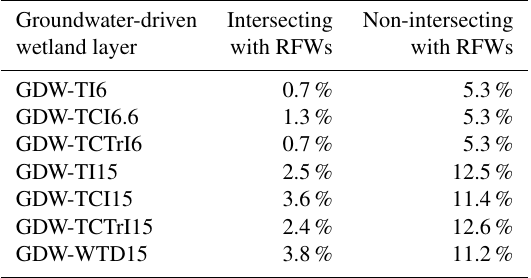
Table 4. Percent of overlap between GDWs and RFWs (percent of total land